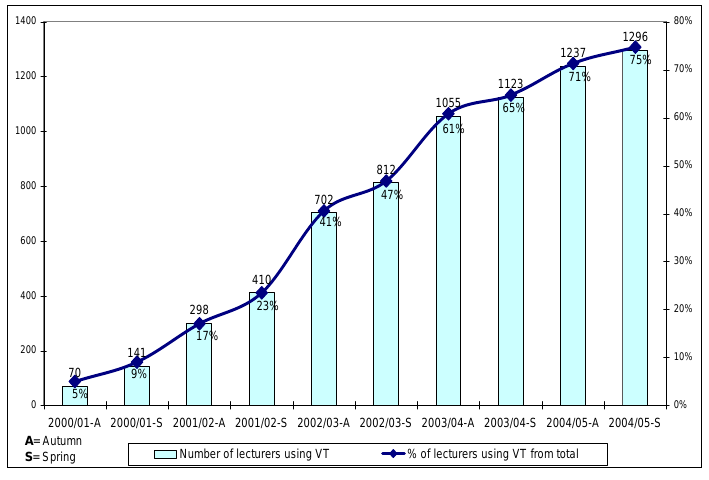
Figure 2. Growth rate in the number of instructors using Virtual